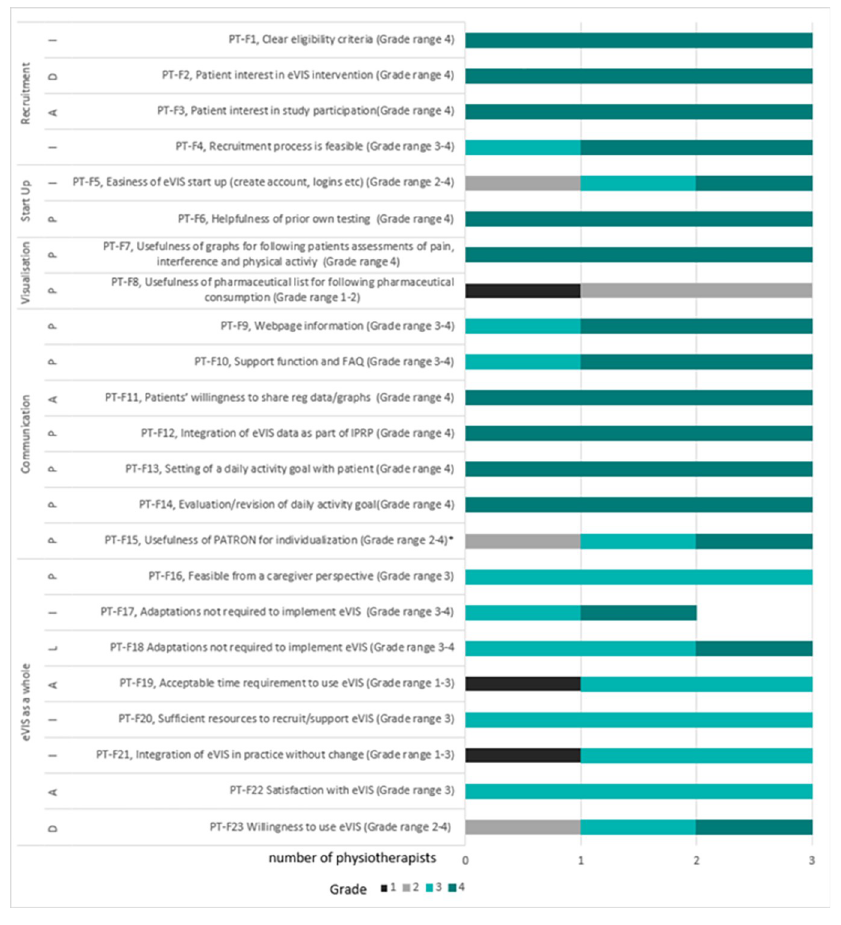
Fig 4. Evaluation of feasibility in a clinical context. Ratings post IPRP by physiotherapists (n = 3). Domain-specific explications of grades 1: Not at all, 2: To some extent, 3: To a rather large extent, 4: To a large extent. Item PT-F23 was rated as extent of agreement with a statement from 1: Strongly disagree to 4: Strongly agree. Ratings � 3 = satisfactory feasibility. Abbreviations: IPRP = Interdisciplinary pain rehabilitation program, P = Practicality, I = Implementation, A = Acceptability, L = Limited Efficacy testing, D = Demand. � PT-F15, one physiotherapist follow up was not possible, due to other non-related